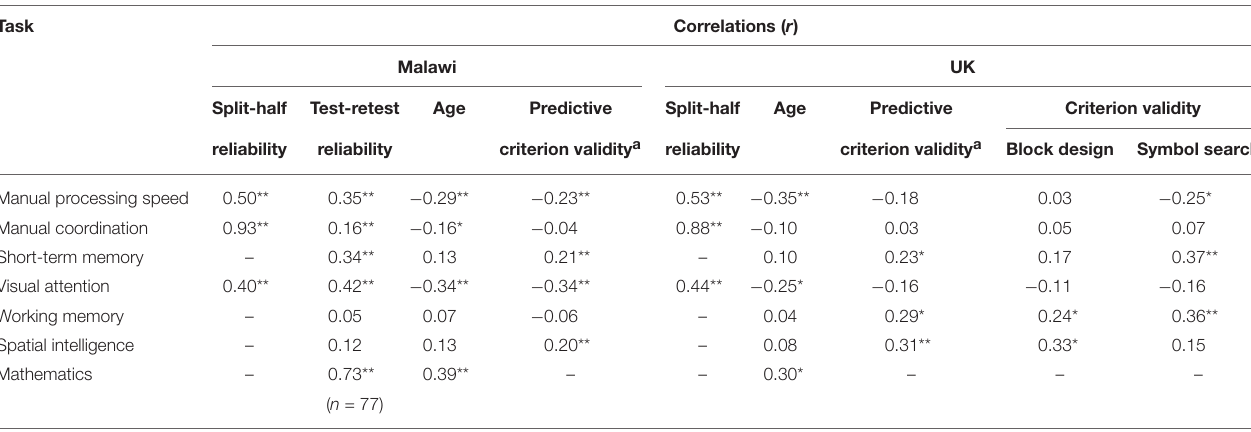
TABLE 2 | Reliability and validity analyses for Malawi and UK